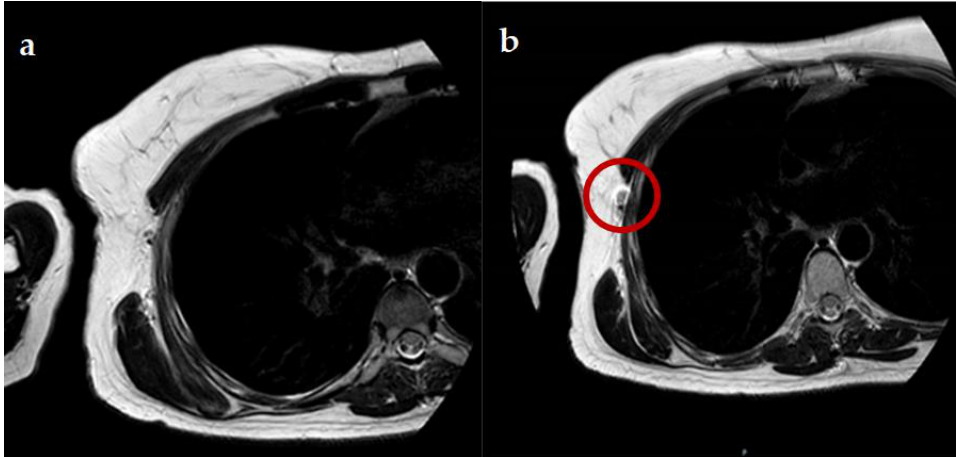
Figure 1. ( a , b ). Visualization of SLN with MRI before and after SPIO. In an enhancement of the SLN is visualized after injection of SPIO. The red circle visualizes the enhanced SLN after the injection of SPIO.